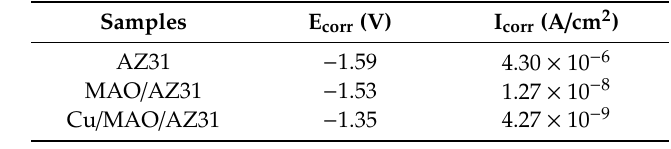
Table 2. Parameters for the Tafel polarization method.